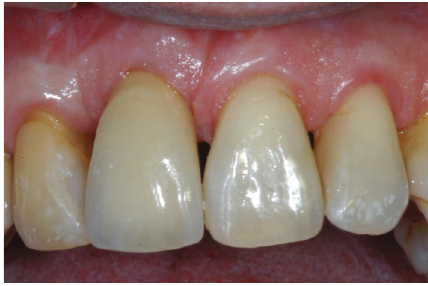
Figure 22: Two-year control. The implant was in function, showing an excellent aesthetic integration; clinical examination showed absence of gingival recession, no probing pocket depths, and no bleeding on probing or suppuration.